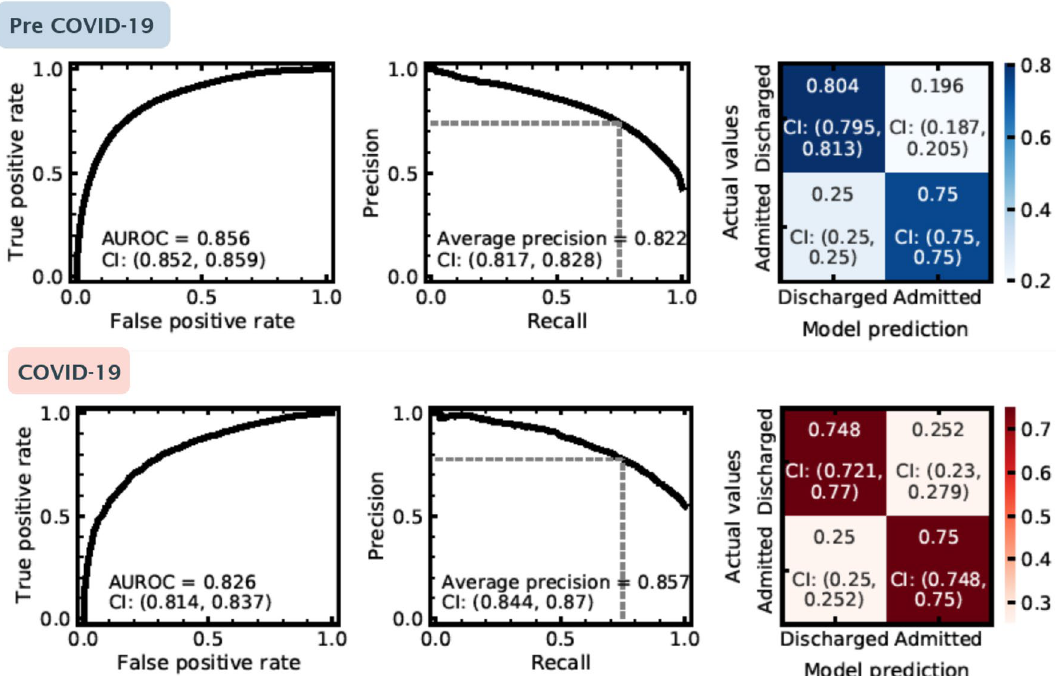
Figure 4. Performance of our admissions model evaluated pre COVID-19 (blue, top row) and during COVID-19 (red, bottom row). Panels left to right represent: (1) Receiver operating characteristic curve for the model’s predictions, (2) Precision recall curve for predictions on the test set, the dashed grey line shows the configuration evaluated in the confusion matrix in ( c ), and (3) Confusion matrix for admission predictions. Each panel shows the 2.5%, 97.5% confidence intervals on presented values, evaluated using bootstrapping (see main